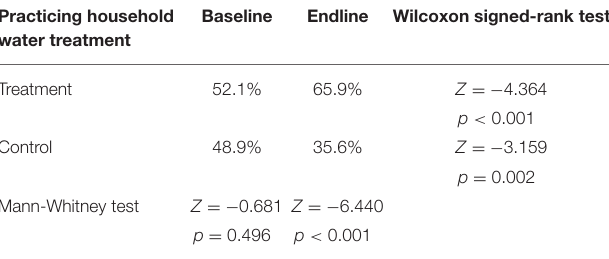
TABLE 4 | Percentage of households that reported practicing household water treatment in the treatment and control systems at baseline and endline, including comparison from baseline to endline with the Wilcoxon signed-rank test and at baseline and endline with the Mann-Whitney